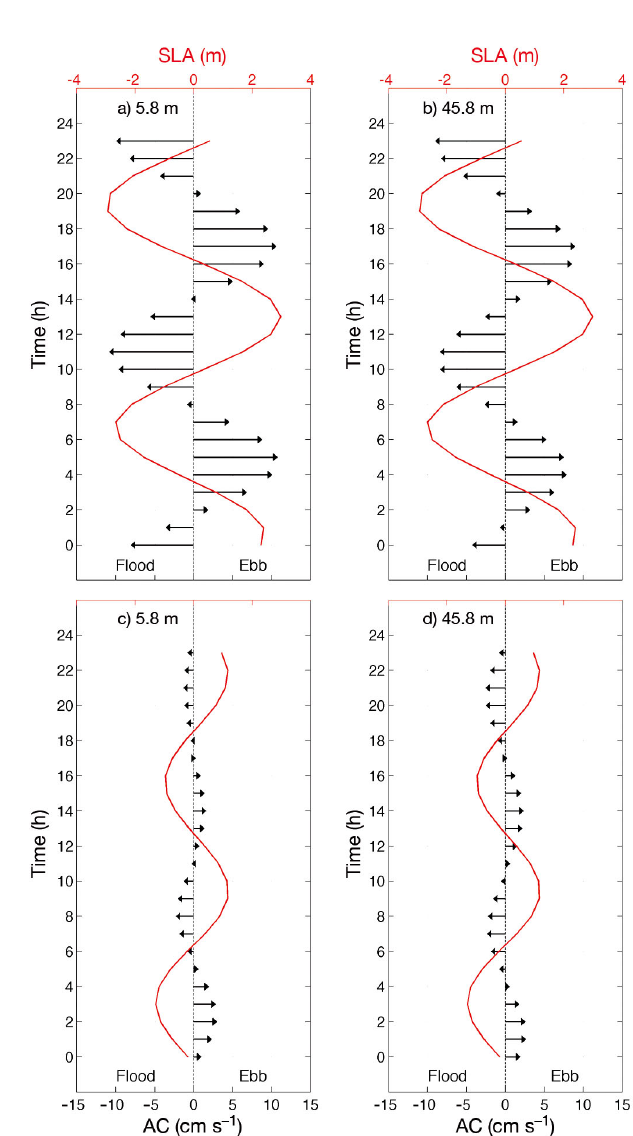
Fig. 5. Semidiurnal sea level anomalies (SLA, solid red line) and semidiurnal along-channel (AC) tidal currents (black arrows). During spring tides (16 May 2011): (a) surface and (b) bottom. During neap tides (26 May 2011): (c) surface and (d)